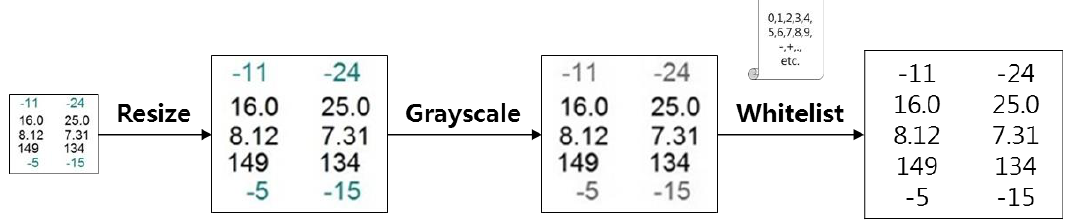
Figure 4. Optimized CIMI pre-processing algorithm for pulmonary function testing (PFT) test sheets.